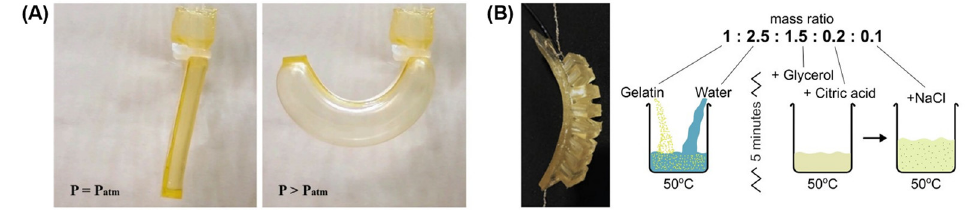
Figure 3. Pneumatically-stimulated bending actuators. ( A ) Biodegradable actuator under non-pressurized and pressurized states [66]. ( B ) PneuNet actuators made of gelatin and glycerol are used as grippers to apply a force that picks up objects [23,28]. (Images ( A , B ) are licensed under CC BY 4.0